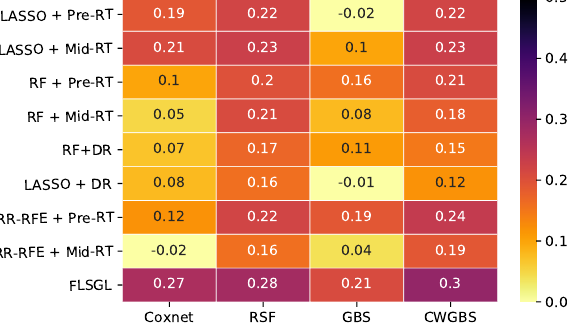
Figure 6. Heatmap of IPA values of overall survival prediction for different feature selection and survival analysis algorithms using FDG-PET radiomics (DR—delta radiomics; Coxnet—Cox net survival model; RR-RFE—ridge regression recursive feature elimination; RF—random forest; RSF— random survival forest; GBS—gradient boosting survival; SSVM—survival support vector machine; GBS—gradient boosting